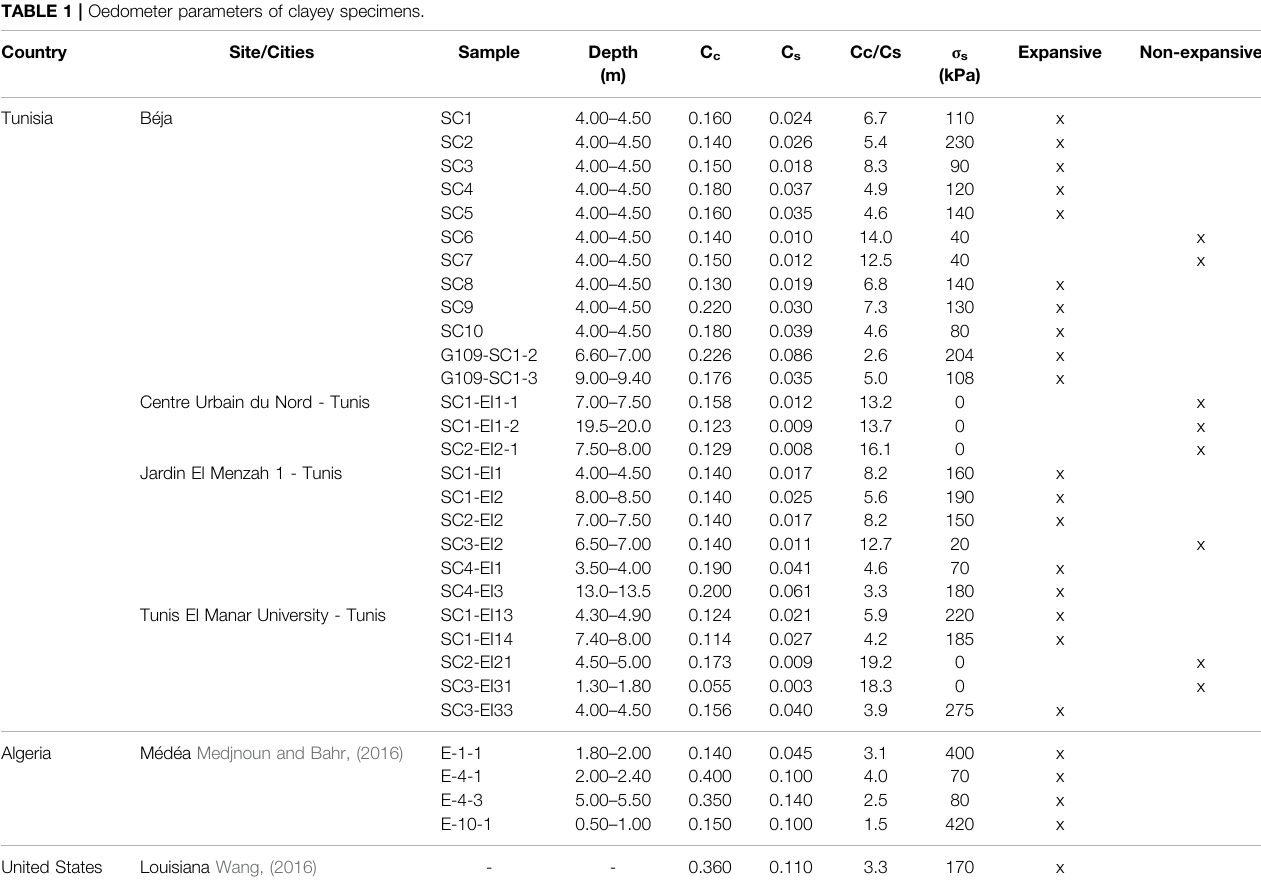
TABLE 1 | Oedometer parameters of clayey specimens. Country